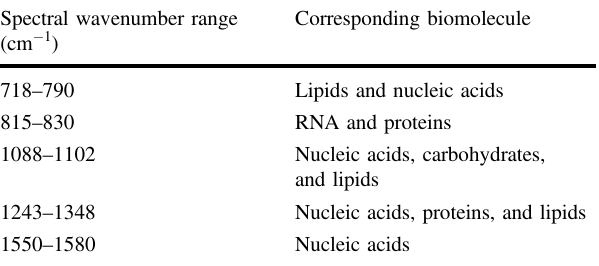
Table 1 Typical Raman spectral ranges for a single cell and the biomolecules corresponding to that range [21] Spectral wavenumber range (cm − 1